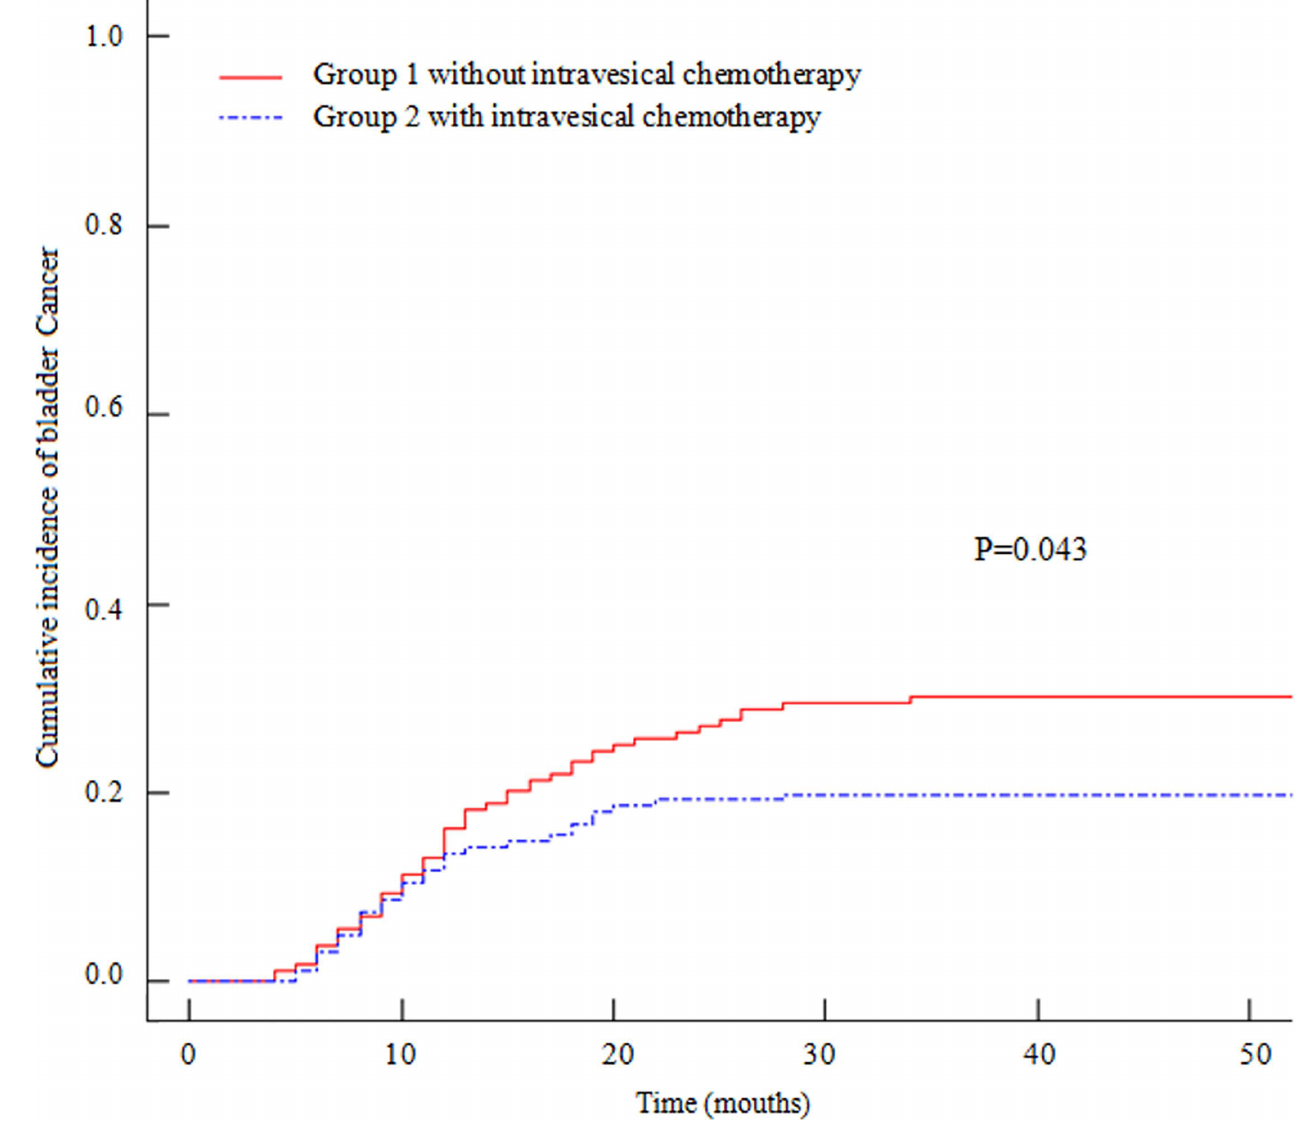
Fig 2. Cumulative Incidence Plot of Tumor Recurrencein the Bladder According to Groups. The cumulative incidencerates at 1 and 3 years after radical nephroureterectomy were 16.4% and 30.2%, respectively, in group 1 and 13.7% and 19.9%, respectively,in group 2 (P =